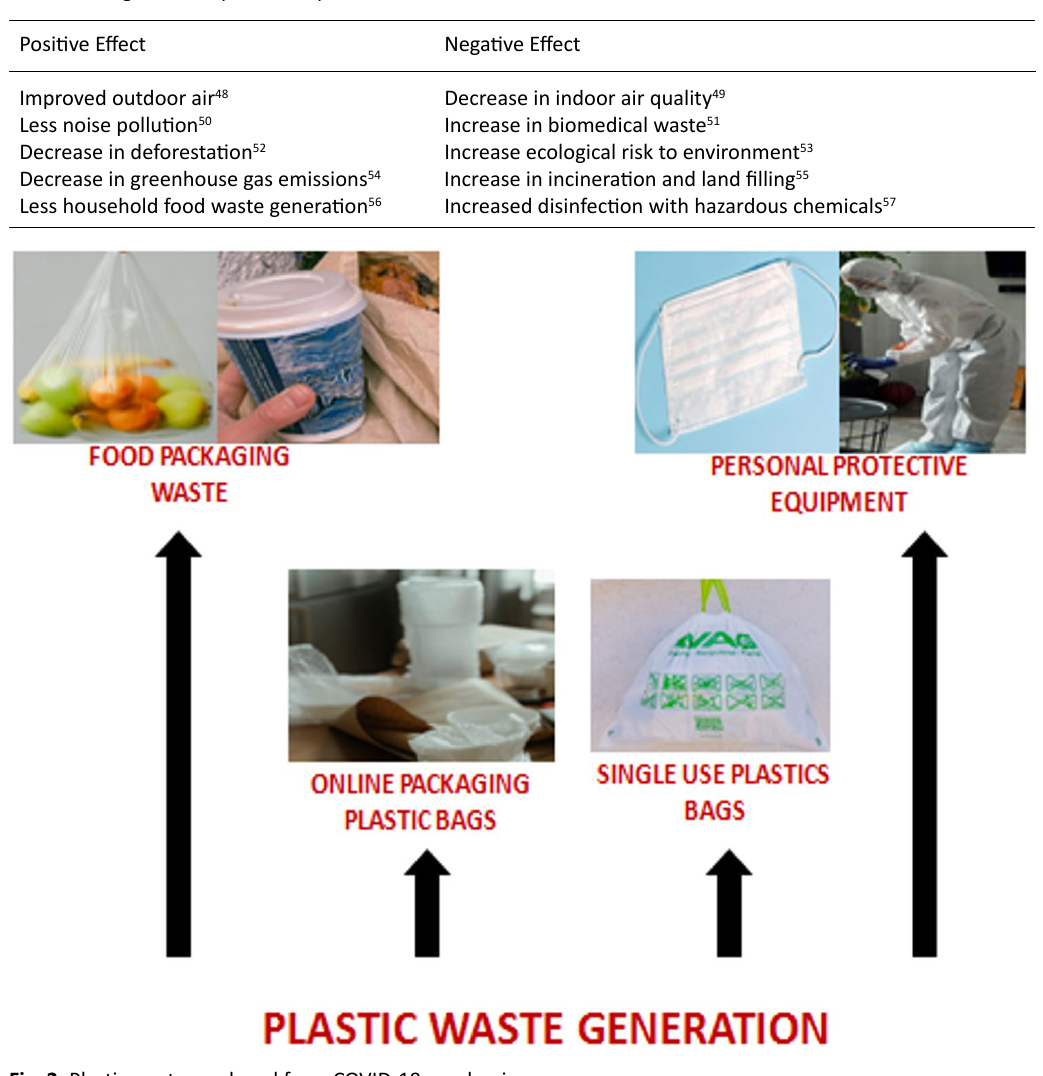
Table 1. Negative and positive aspects of COVID-19 on